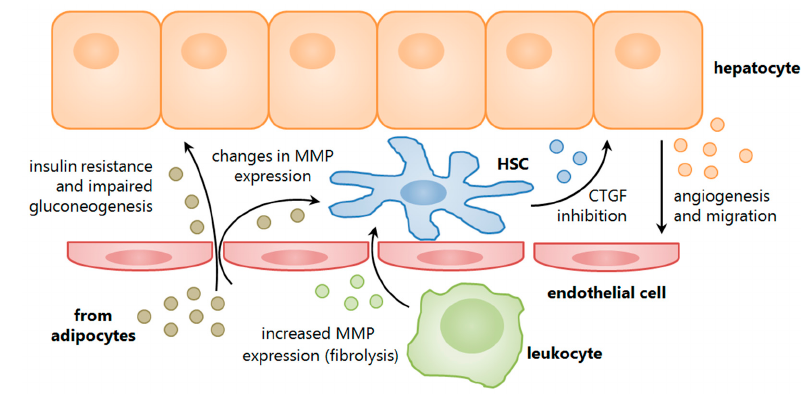
Figure 2. Extracellular vesicle roles in non-alcoholic fatty liver disease (NAFLD). EVs are involved in